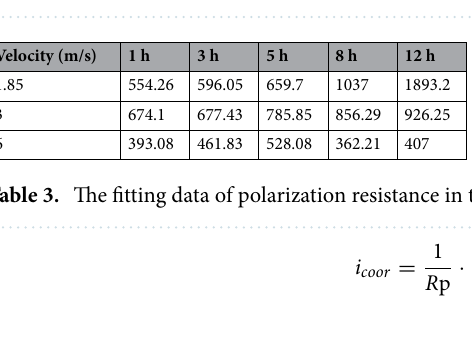
Figure 12. LPR curves of three zones of B10 alloy welded joint at 1.85 m/s, 3 m/s and 6 m/s after 12 h of flowing seawater corrosion: ( a ) BM, ( b ) HAZ, ( c ) WM, (1) 1.85 m/s, (2) 3 m/s, and (3) 6 m/s.